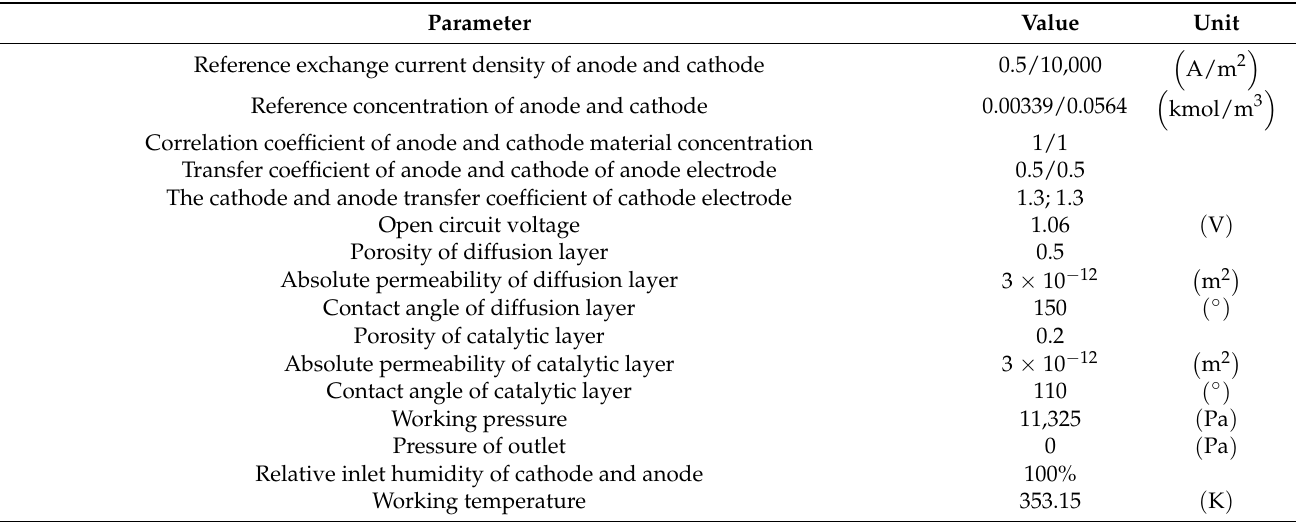
Table 2. Material parameters and boundary conditions of model.